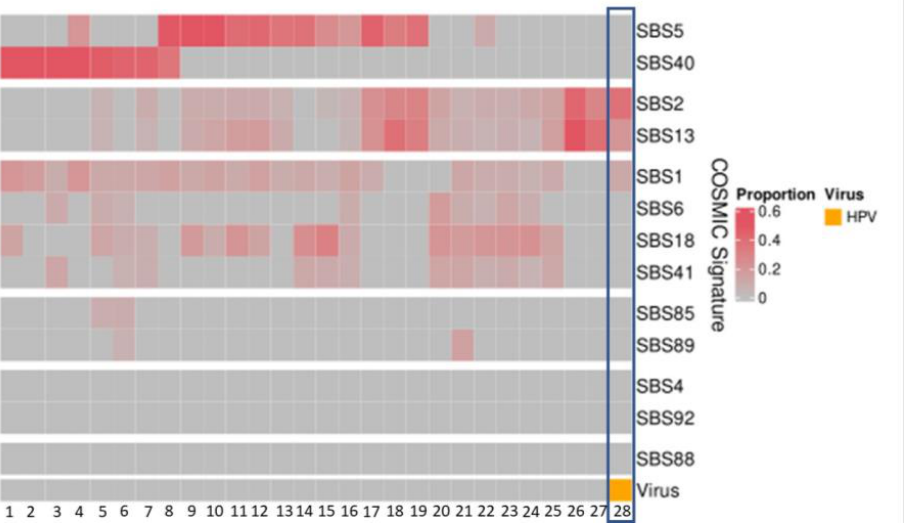
Figure 3. Mutational signatures (COSMIC3) of patient cohort ( n = 28). The HPV-positive patient (patient 28 with HPV35) demonstrates high proportions of SBS2 and SBS13.